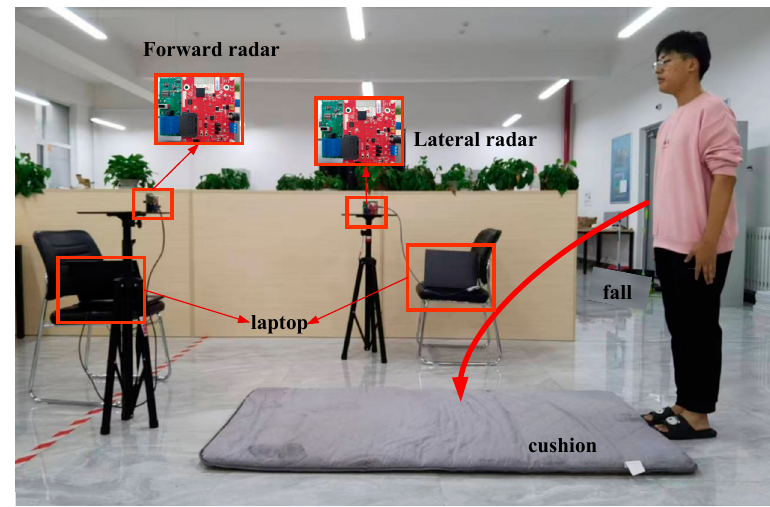
Figure 11. Experiment scene diagram.